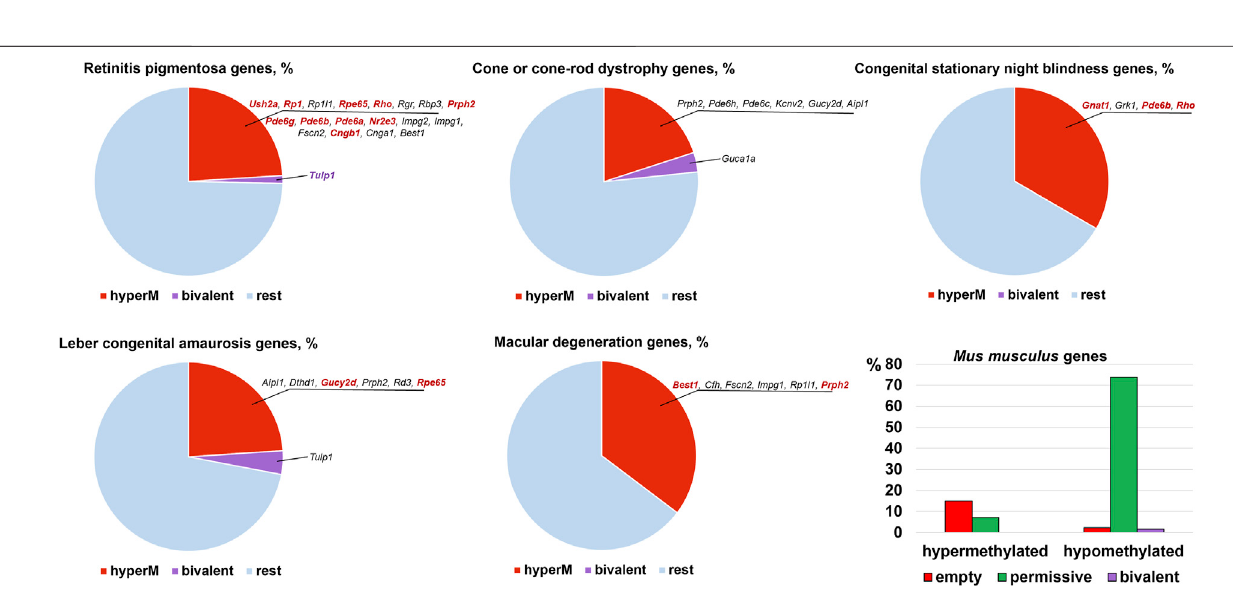
state. Except RPE65 , mutations in the genes may not account for a substantial number of LCA cases ( Supplementary Data S2 ). (6 genes) RPCs. The genes whose promoters were